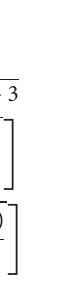
, κ ). (Aa) F calculated with ( D e, ; D e, ) (2.10; 0.74) and SNR = k || ⊥ ; D e, ) (0.32; 0.85) and SNR , thus containing the second local minimum of the 5D = = ∞ || ⊥ 50. (Ad) The same as (Ab) , but SNR 50. The theoretical minimum of F along each pipe is identified by a = =